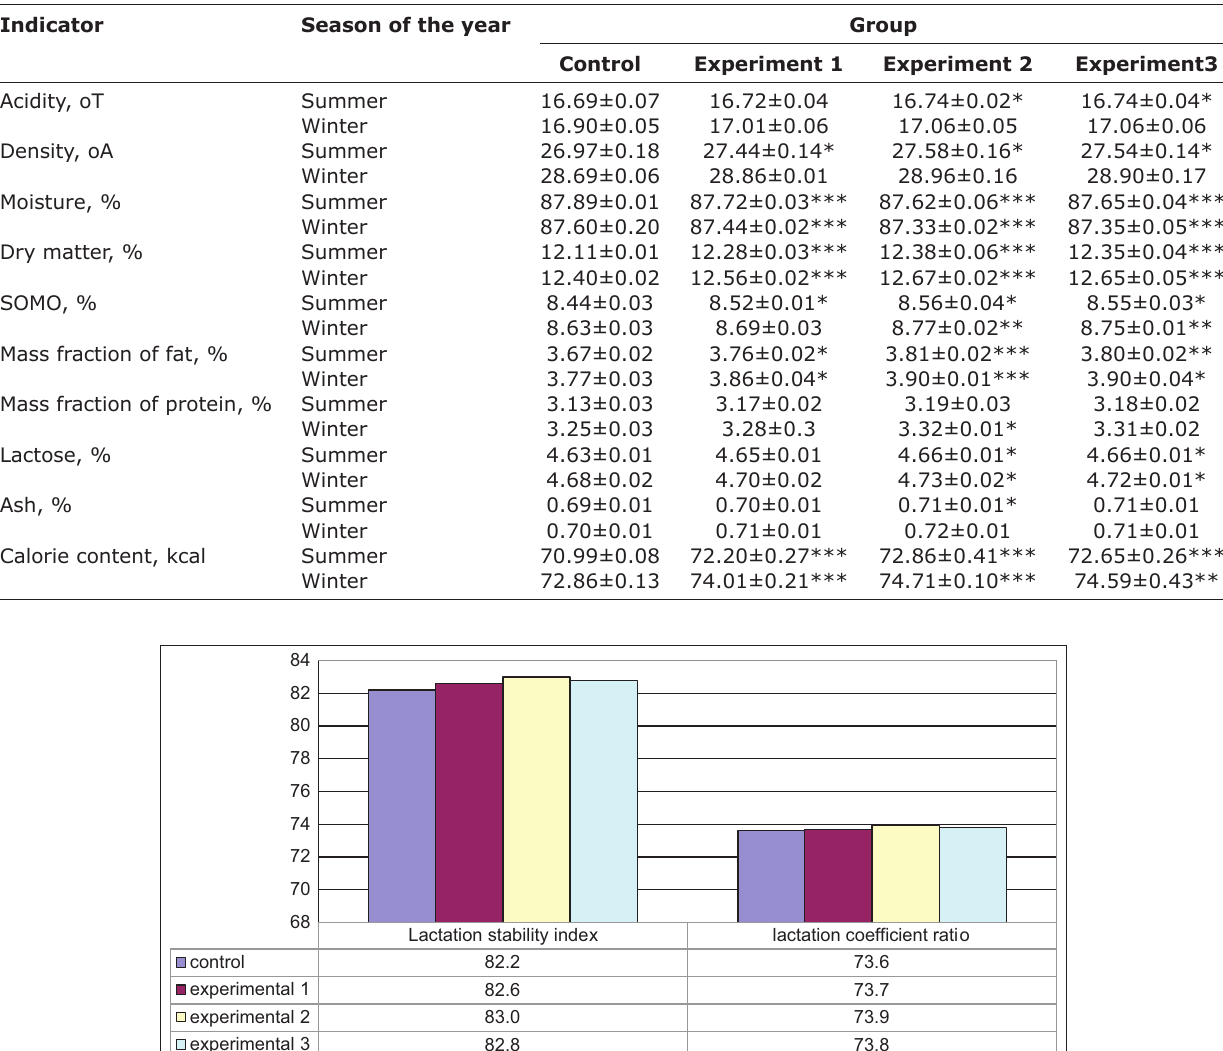
Table-3: Chemical composition and quality of milk.